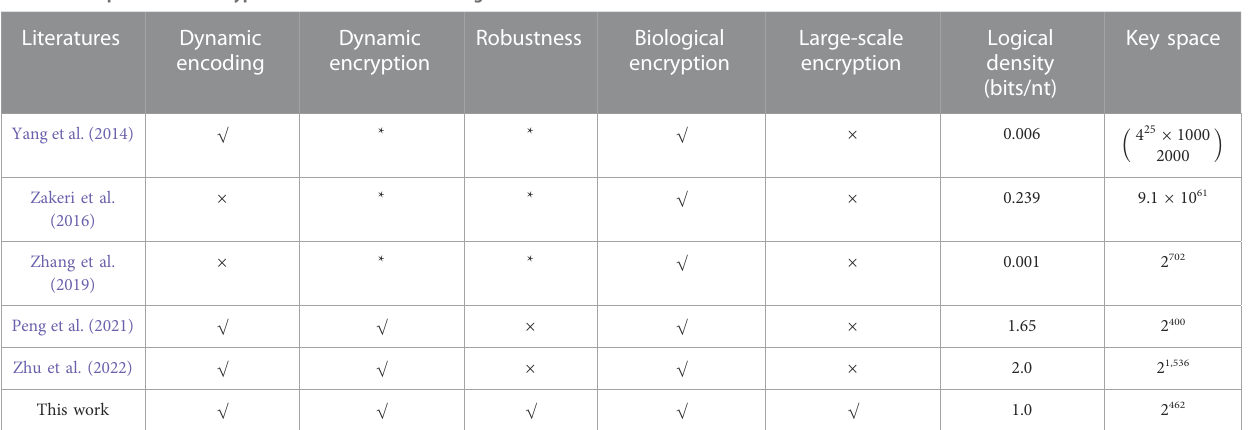
TABLE 2 Comparisons of encryption methods for DNA